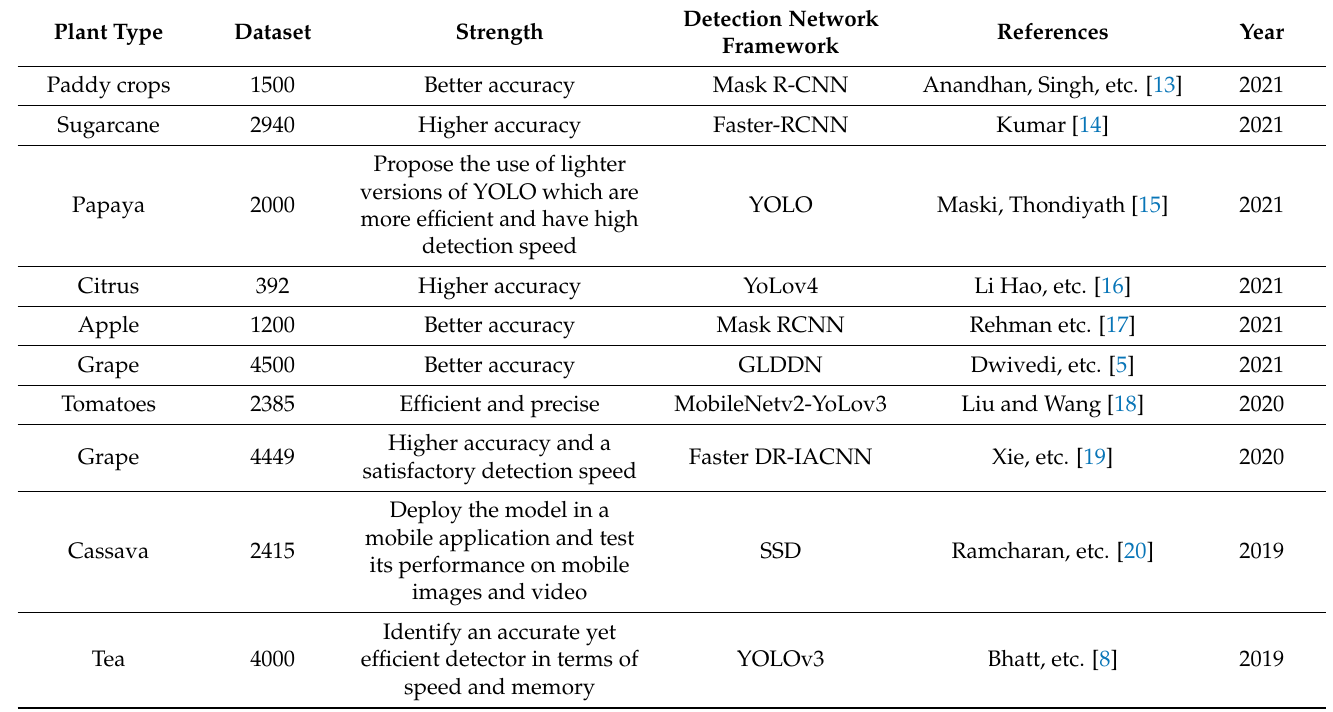
Table 1. Summary of related work on plant disease